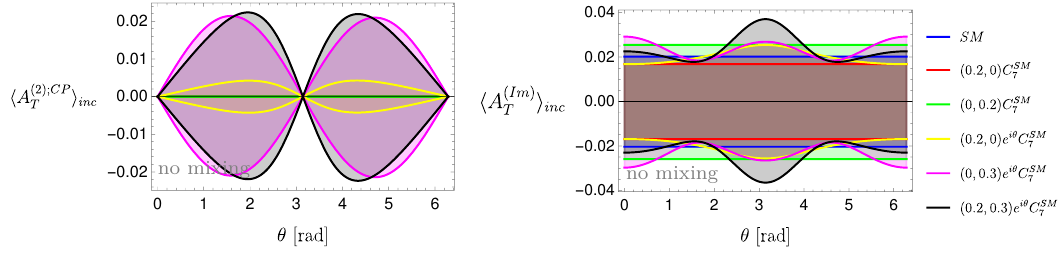
i inc and h A ( Im ) i inc in the bin q 2 ∈ [0 . 0008 , 0 . 257] GeV 2 . For T T